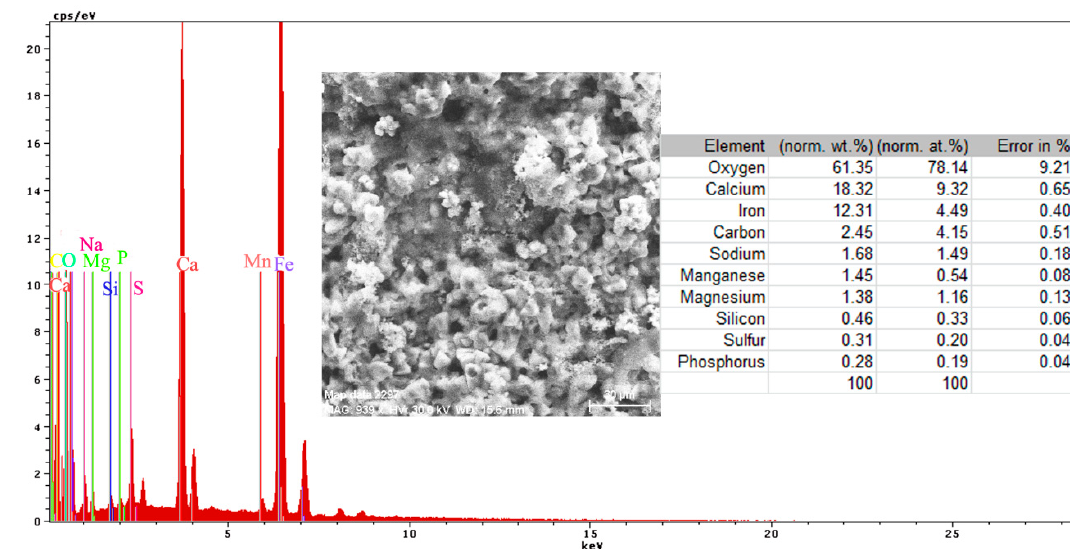
Figure 18. Energy spectrum and surface composition for the crust formed on the PPS surface, after 78 days of immersion in BSW.